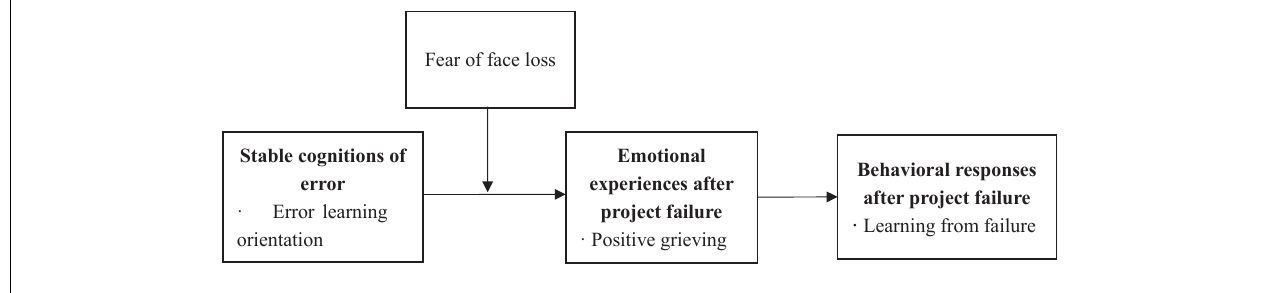
FIGURE 1 | Theoretical